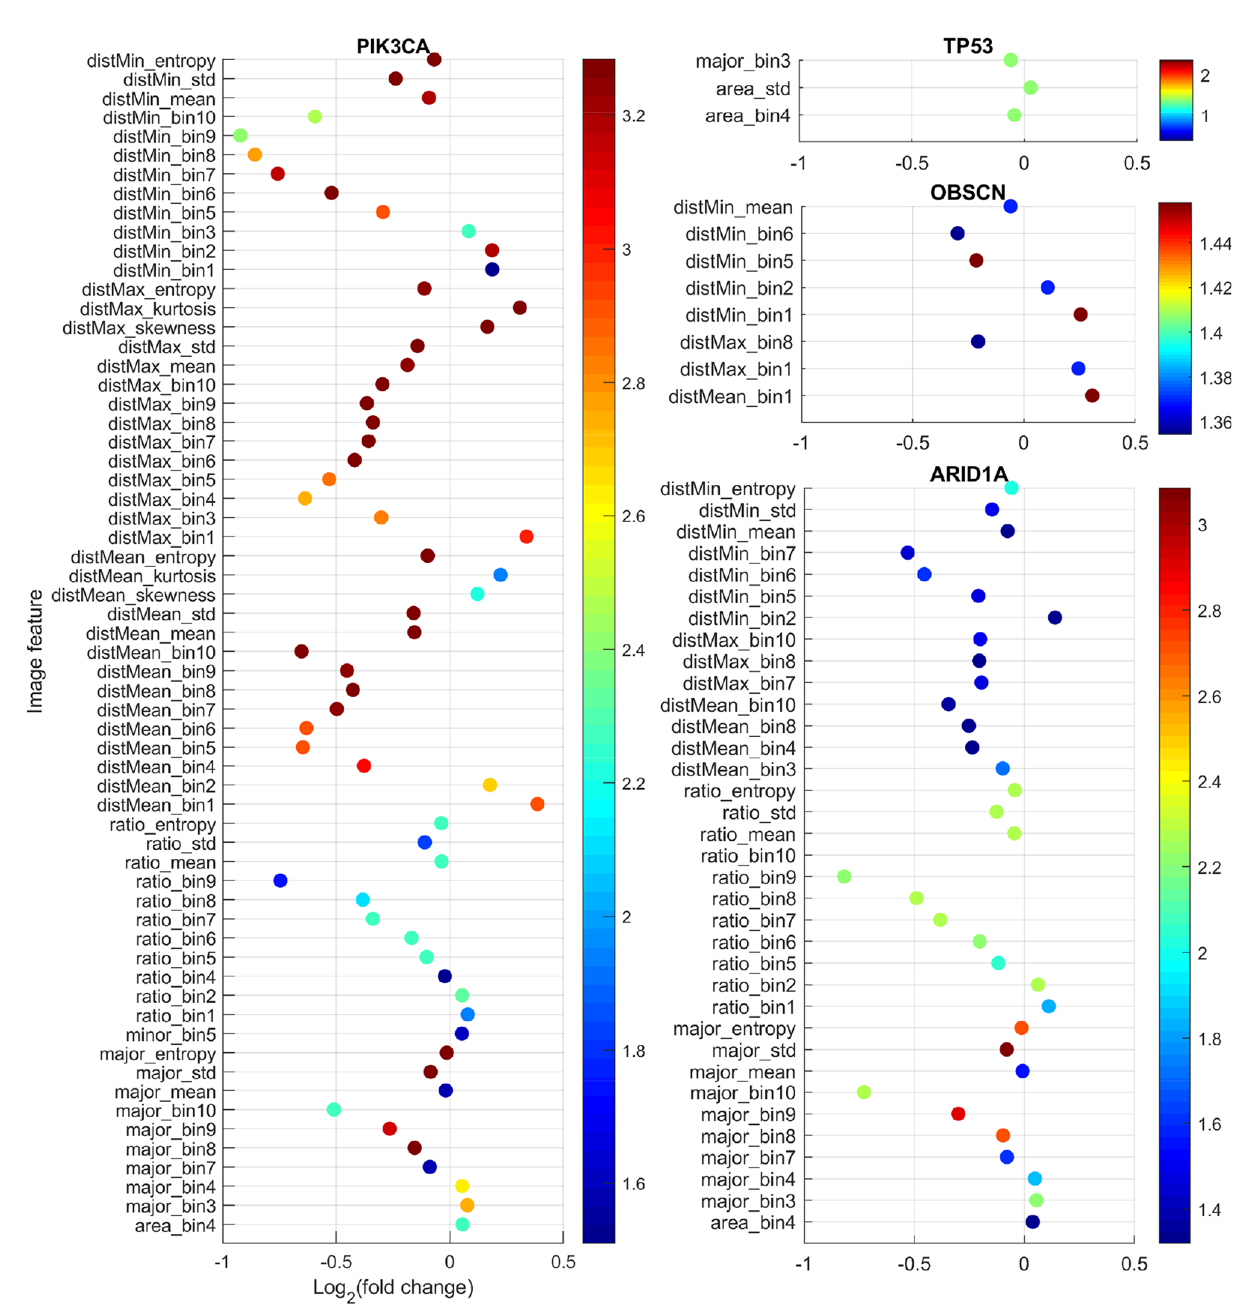
FIGURE 2 | Comparison of image features with respect to somatic mutation status. For each feature, the fold change is the ratio of the median feature values between the mutated group and nonmutated group (mutated/nonmutated), and the color scale is the negative logarithm of q-value. The dots ’ color corresponds to the scales of the side color